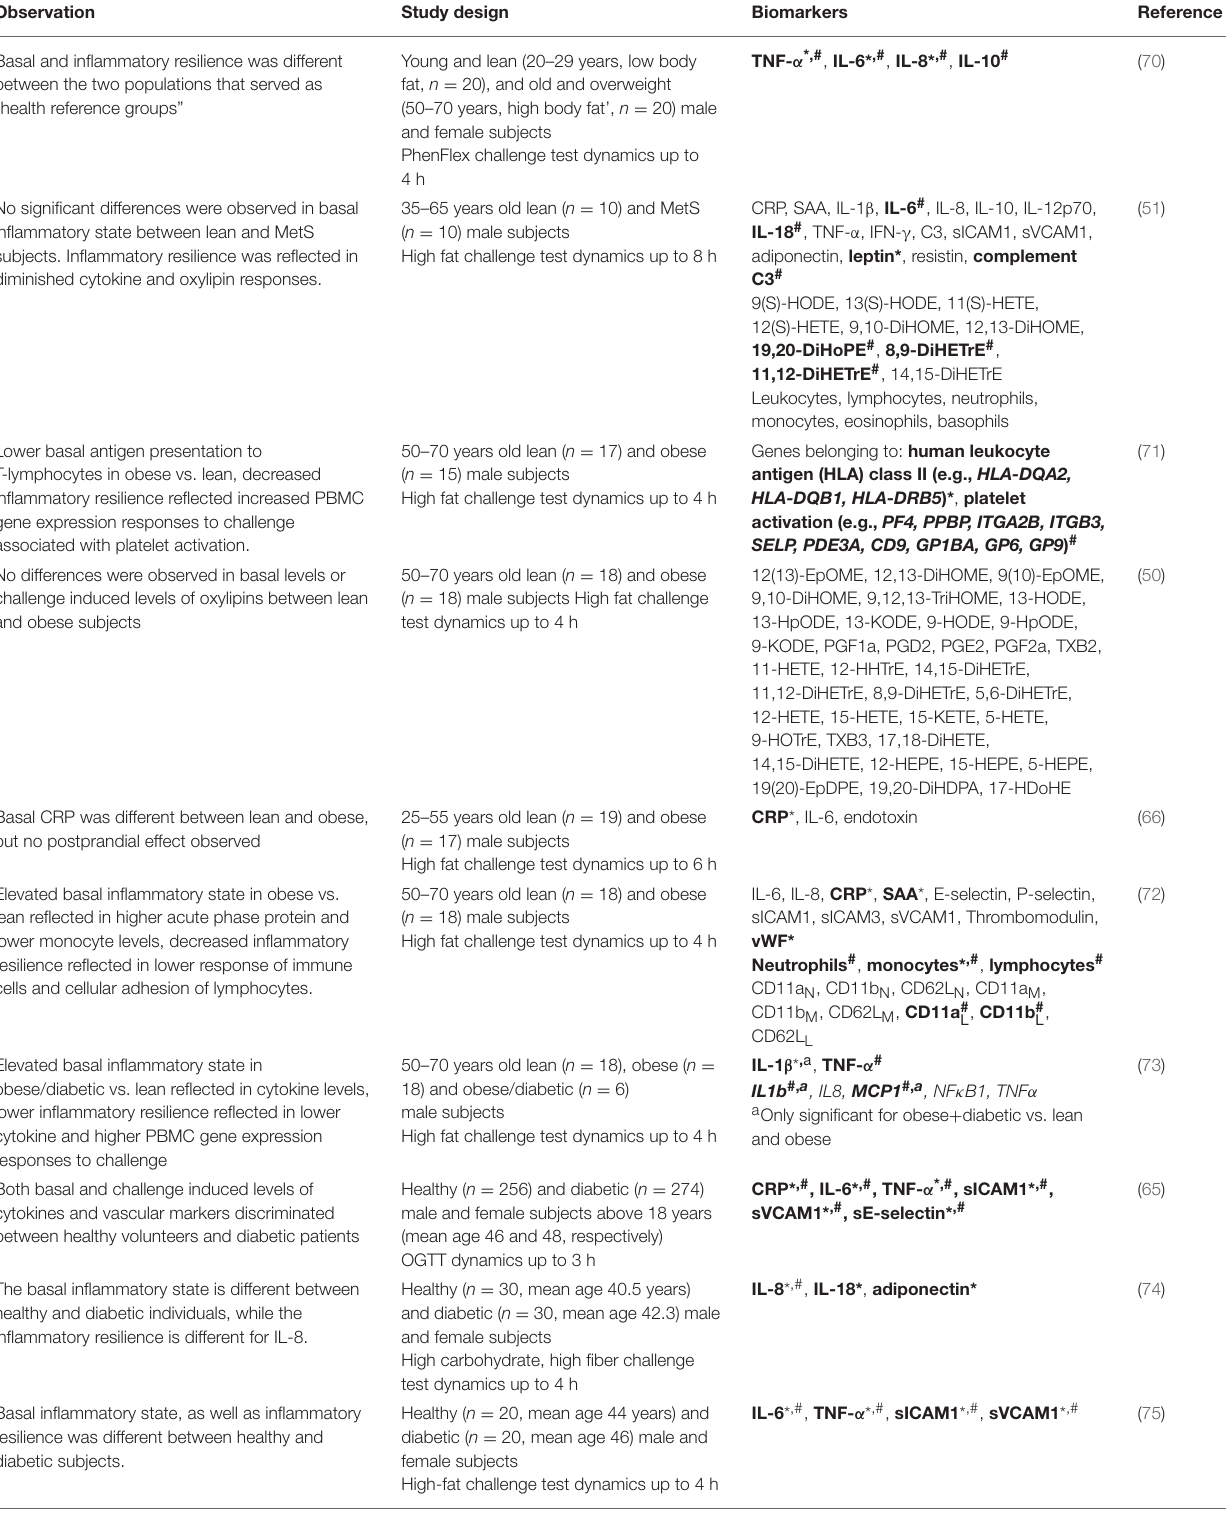
TABLE 2 | Metabolic challenge tests to diagnose chronic low-grade inflammation in metabolic disorders. Observation Study design Biomarkers Reference Basal and inflammatory resilience was different between the two populations that served as “health reference